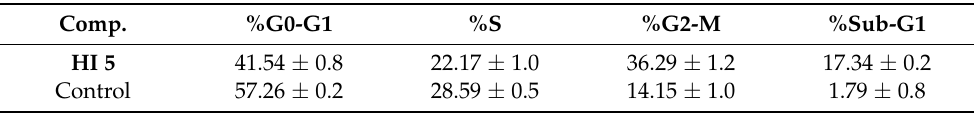
Table 5. Results of cell cycle analysis in MCF-7 expressed by (%) of cell in each phase when treated with compound HI